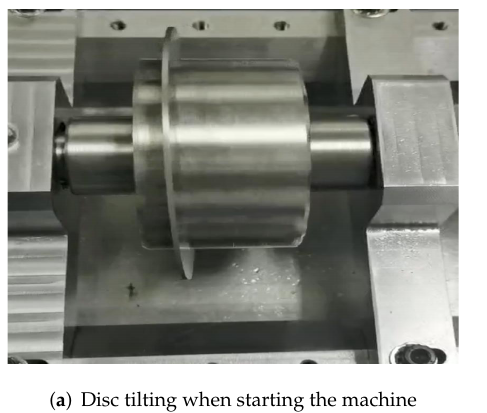
Figure 2. Rigid-body tilting of the spinning